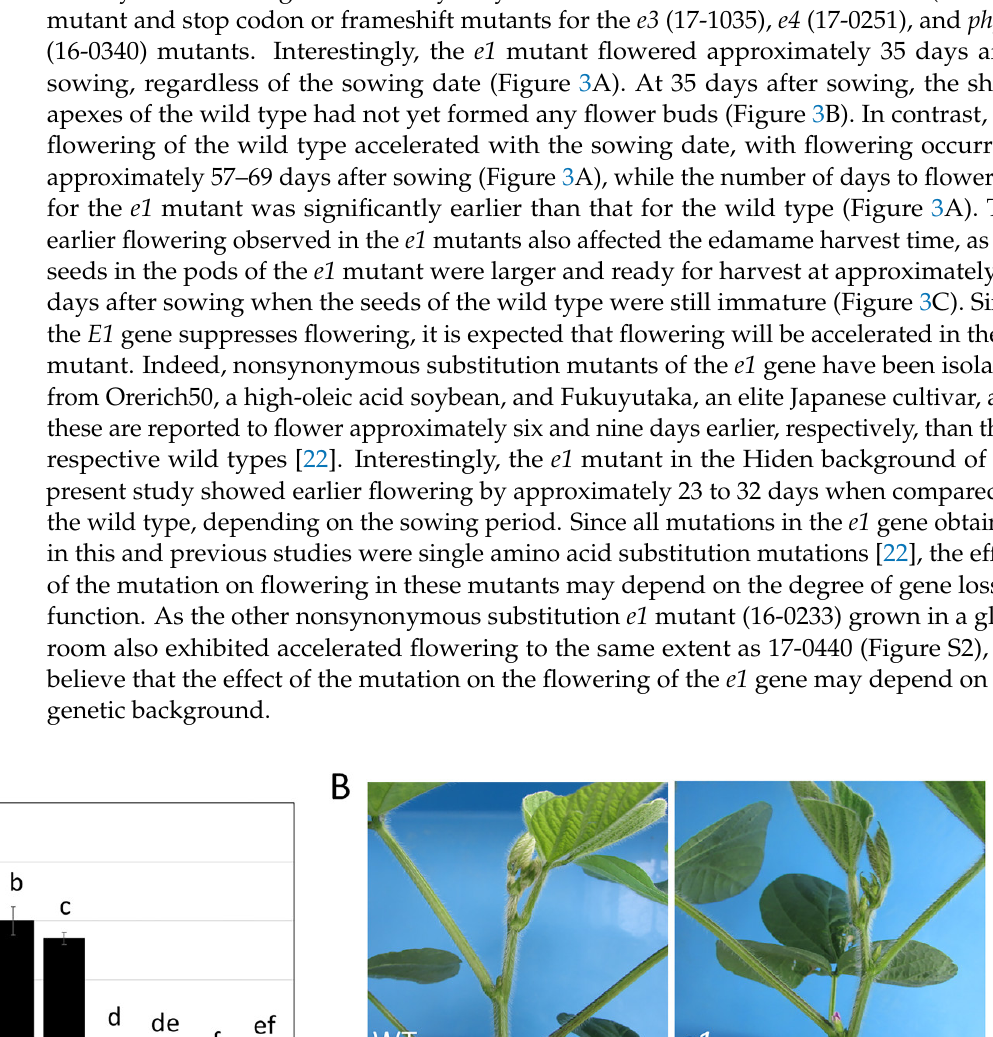
Figure 4. Days to flowering for the wild type, e3 (17-1035), e4 (17-0251), and phya1 (16-0340) mutants sown in early June. Data are expressed as the average with standard deviation (n = 10). * Student’s t -test, * p < 0.01. 2.4. DNA Marker Development for Breeding Applications The breeding of edamame varieties that can be harvested in a timely manner for ship- ment to meet demand is an important breeding target. Although DNA markers are essen- tial for the utilization of specific alleles during breeding, most of the mutant alleles